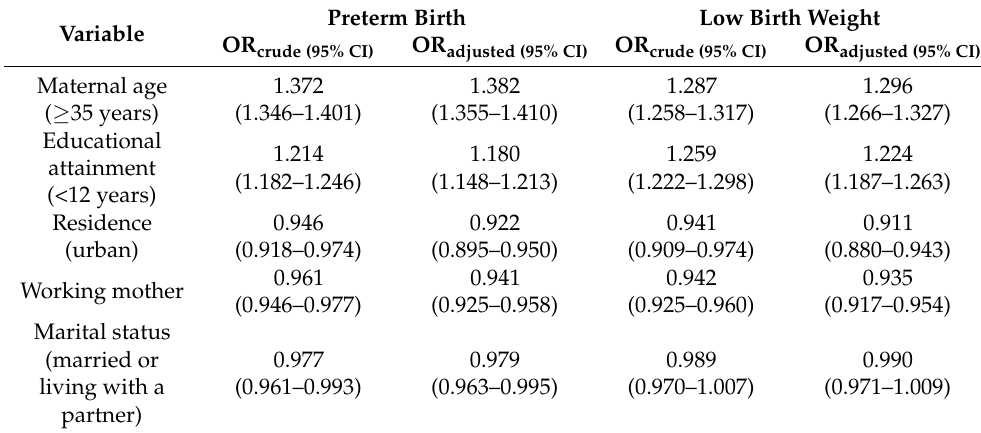
Table 3. Multiple logistic regression model for the association between preterm birth, low birth weight, and maternal